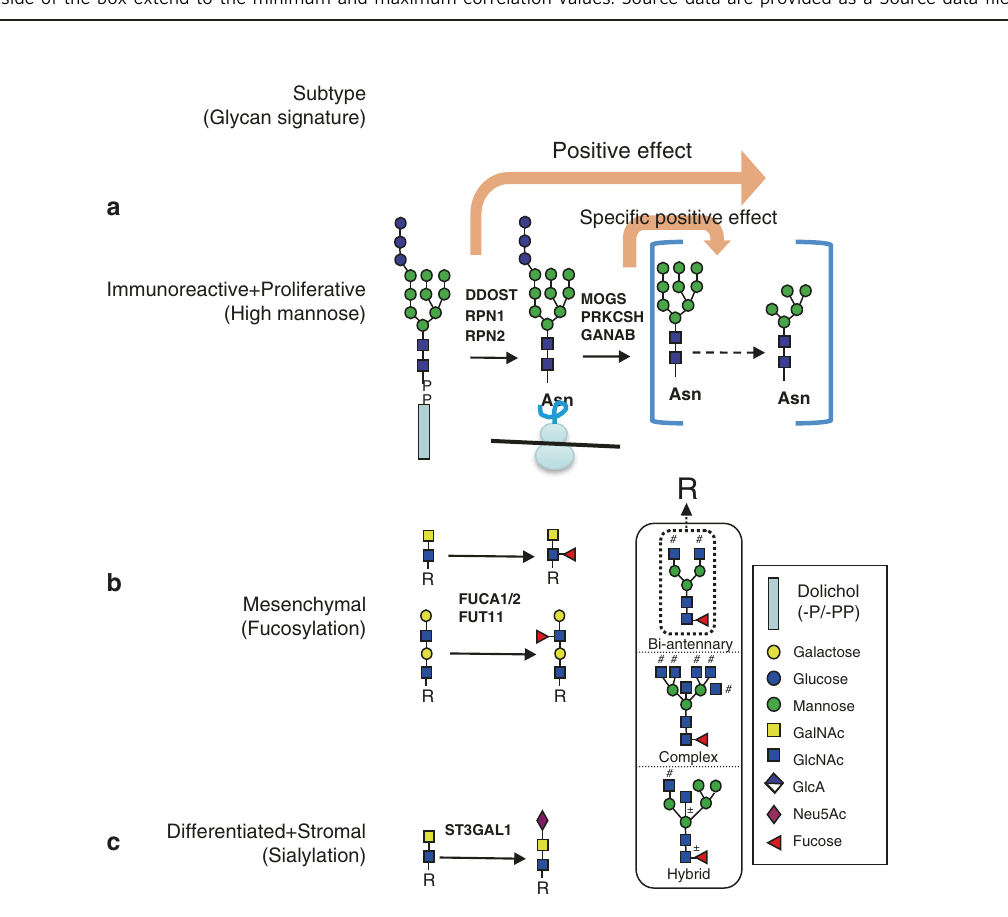
Fig. 6 Heatmap of expression correlation between N-linked glycosylation enzyme and intact glycopeptides with different glycans. a Bi-clustering was performed on correlations between intact glycopeptides (column) and glycosylation enzyme expression in total protein level (row) across 119 tumor samples. Red indicates positive correlation while blue indicates negative correlation. b Boxplot panel of the correlation difference between enzyme expression (protein level) and speci fi c intact glycopeptides. For PRKCSH, n (No) = 128 glycopeptides, n (Yes) = 47 glycopeptides, p = 1.84e-15 (Yes vs. No); For MAN1A1, n (No) = 128 glycopeptides, n (Yes) = 47 glycopeptides, p = 4.93e − 17 (Yes vs. No); for FUCA1, n (No) = 97 glycopeptides, n (Yes) = 78 glycopeptides, p = 4.10e − 4 (Yes vs. No); for ST3GAL1, n (No) = 117 glycopeptides, n (Yes) = 58 glycopeptides, p = 9.04e − 7 (Yes vs. No).